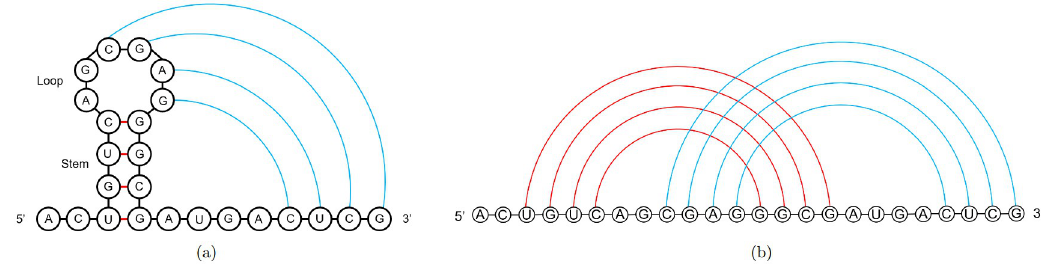
Fig 3. Pseudoknot diagram. A: Hairpin loop with stem base pairs shown in red. H-type pseudoknot pairing shown in blue between bases in the loop and complementary downstream bases. B: Representation of 3A in which arcs represent base pairs (arc diagram) for display of overlapping